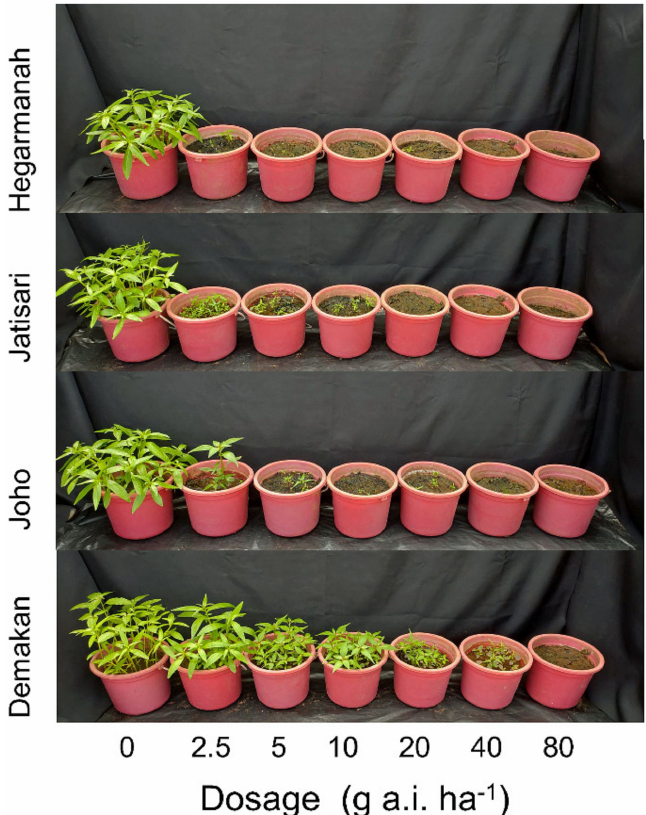
Figure 1. Effect of penoxsulam on four populations of L. decurrens 28 days after herbicide application.